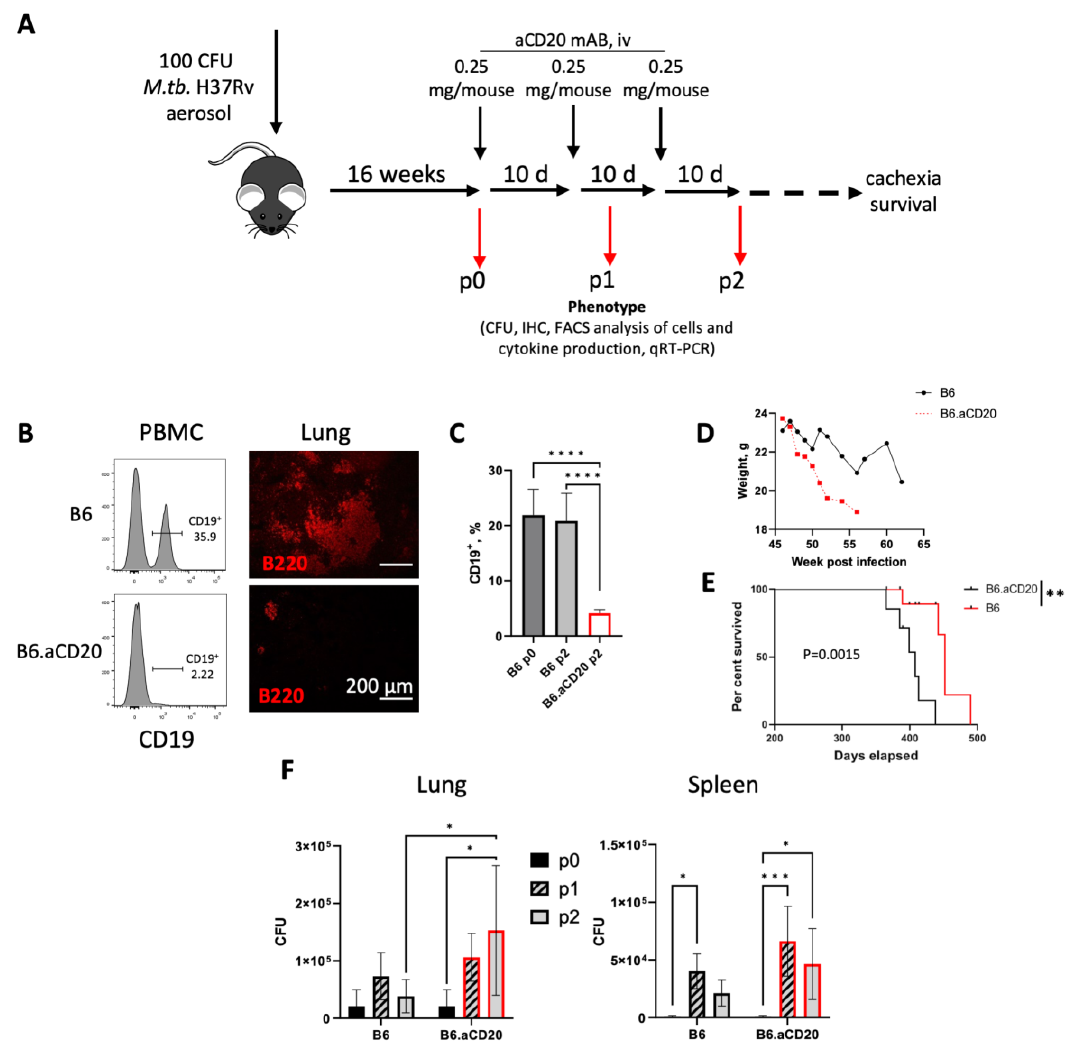
Figure 2. B-cell depletion exacerbates severity of TB at the late stages of infection. ( A ) The scheme of experiments. 0.25 mg of B-cell-depleting anti-CD20 mAbs per mouse per time point were injected intravenously (i.v.) thrice with 10-d intervals. Analyses were performed before treatment (p0) and then at p1 and p2 with 2 wk intervals. ( B ) Efficiency of B-cell depletion as measured by FACS of CD19 + B cells in peripheral blood 2 days after antibody injection (PBMC, left panels); visualization of lung BCFs with anti-B220 antibodies 7 days post-depletion (right panels). ( C ) CD19+ B-cell content in the lungs before treatment (p0) and 30 days post-B-cell depletion (p2). Percent from all lung cells. ( D ) Cachexia in control (B6) and anti-CD20 treated (B6.aCD20) mice. ( E ) Lifespan of control (B6) and aCD20 treated (B6.aCD20) mice. Log-rank test, ** p = 0.0015. ( F ) Mycobacterial counts in lungs and spleens of control B6 and B-cell-depleted (hereafter—red bars) mice at p0, p1, and p2. Data from one of two similar experiments are displayed as mean ± SD, 4–5 mice per group per time-point. * p < 0.05; ** p < 0.01; *** p < 0.001, **** p < 0.0001.